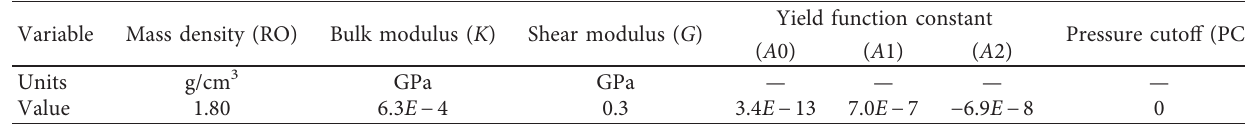
Table 6: Parameters of stemming